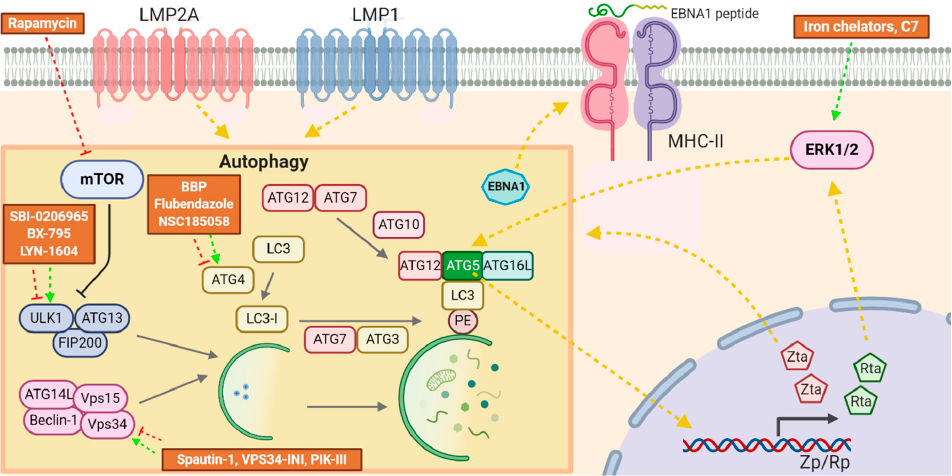
Figure 3. Relationship between induction of lytic cycle of EBV and the autophagy machinery and